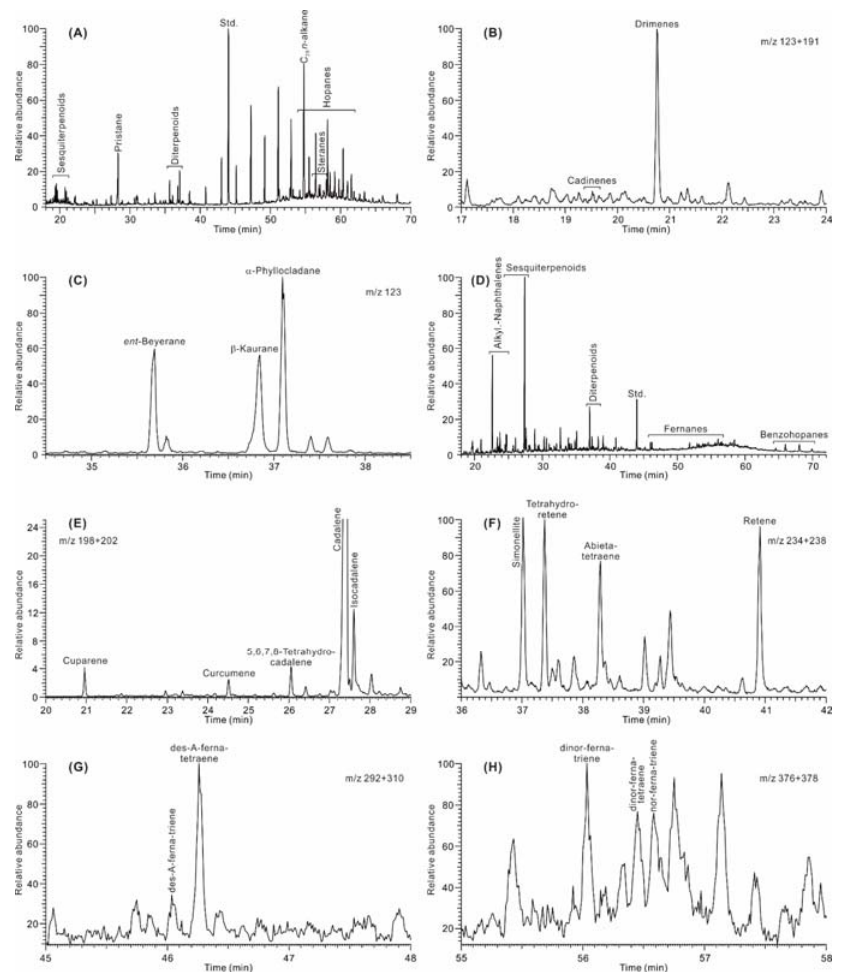
Figure 9. Gas chromatograms and mass chromatograms of a coal sample (L9). ( A ) Gas chromatogram of saturated hydrocarbon fraction. ( B ) Mass chromatogram of sesquiterpenoids (saturated hydrocarbon fraction; m/z 123 + 191). ( C ) Mass chromatogram of diterpenoids (saturated hydrocarbon fraction; m/z 123). ( D ) Gas chromatogram of aromatic hydrocarbon fraction. ( E ) Mass chromatogram of sesquiterpenoids (aromatic hydrocarbon fraction; m/z 198 + 202). ( F ) Mass chromatogram of diterpenoids (aromatic hydrocarbon fraction; m/z 234 + 238). ( G ) Mass chromatogram of fernanes (aromatic hydrocarbon fraction; m/z 292 + 310). ( H ) Mass chromatogram of fernanes (aromatic hydrocarbon fraction; m/z 376 + 378). Std., standard.